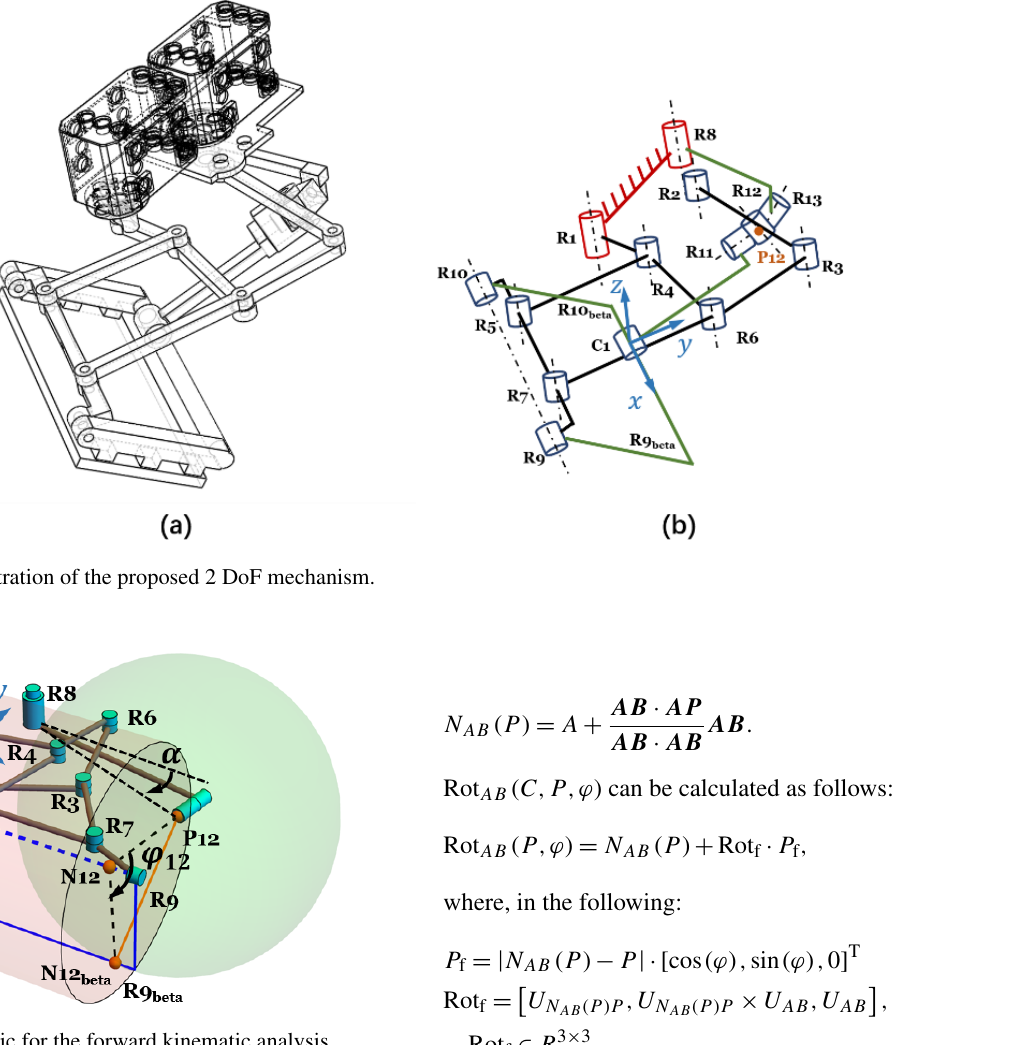
Figure 2. The schematic for the forward kinematic